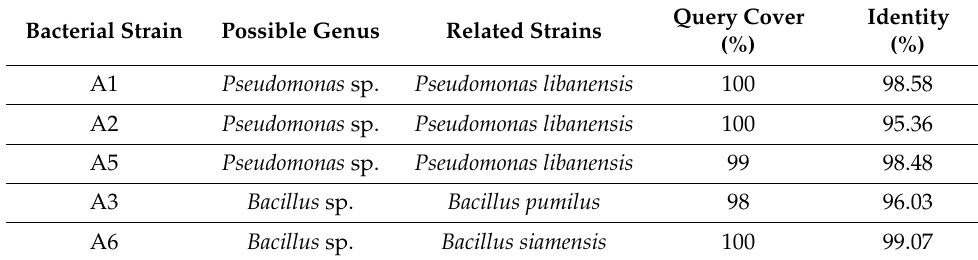
Table 3. Bacterial strains identified through 16S rRNA gene